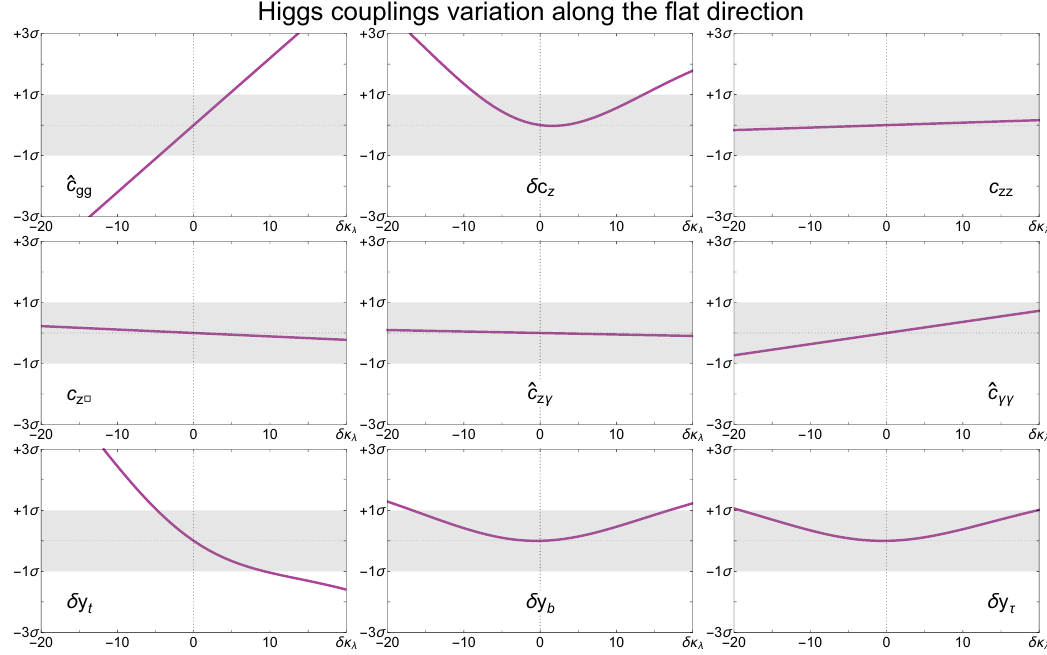
Figure 1 . Variation of the Higgs basis parameters along the (cid:13)at direction as a function of the Higgs trilinear coupling (cid:20) (cid:21) . The gray bands correspond to the 1 (cid:27) error bands at the high-luminosity LHC (see eq.